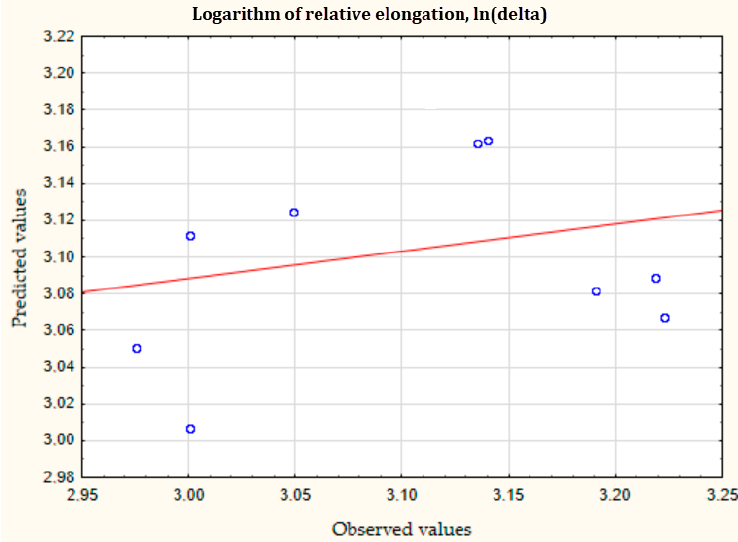
Figure 3. The observed and predicted values of the relative elongation.